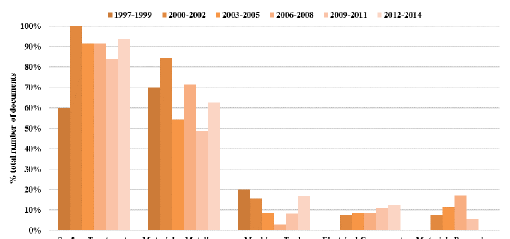
Figure 4. Main Technological Subdomains percentage representativeness of patent documents regarding amorphous alloys processed by thermal spraying between 1997 and 2014. Source: Derwent Innovations Index.